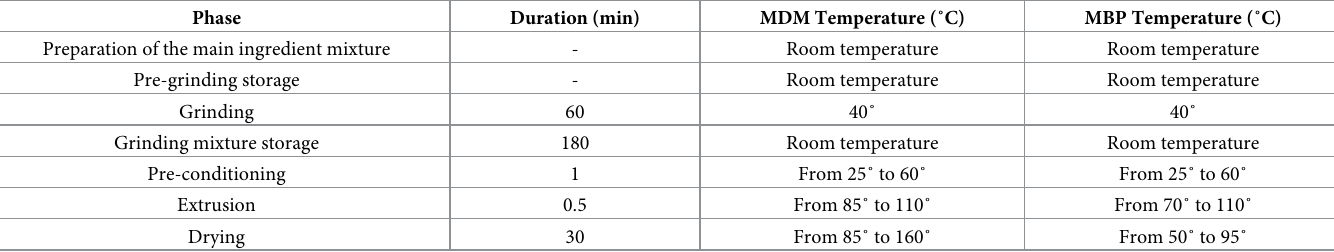
Table 3. Production of MDM (Mechanically Deboned Meat) diet and MBP (Meat By-Products) diet and relative processing temperature, modified by